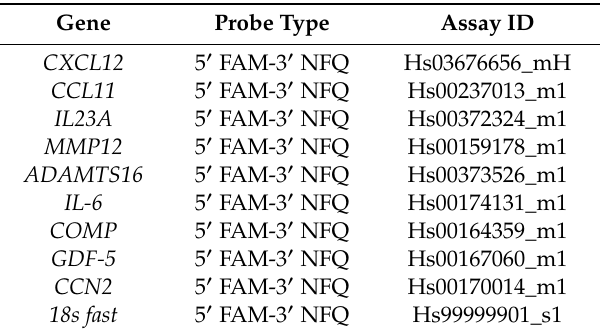
Table 1. Gene expression assays ( human ) used for real-time